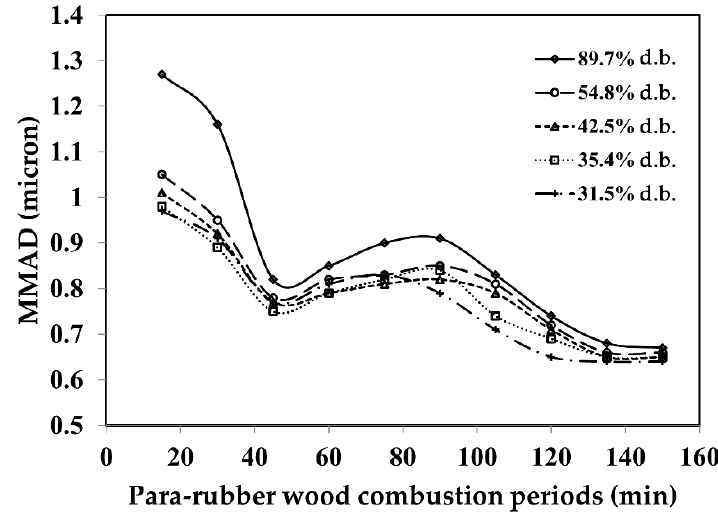
Figure 4. MMAD emission from the para rubber wood combustion for different wood moisture